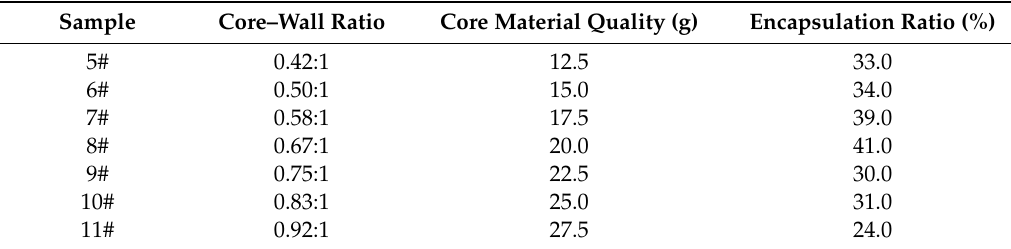
Table 8. Encapsulation ratio results of microcapsules in the single factor